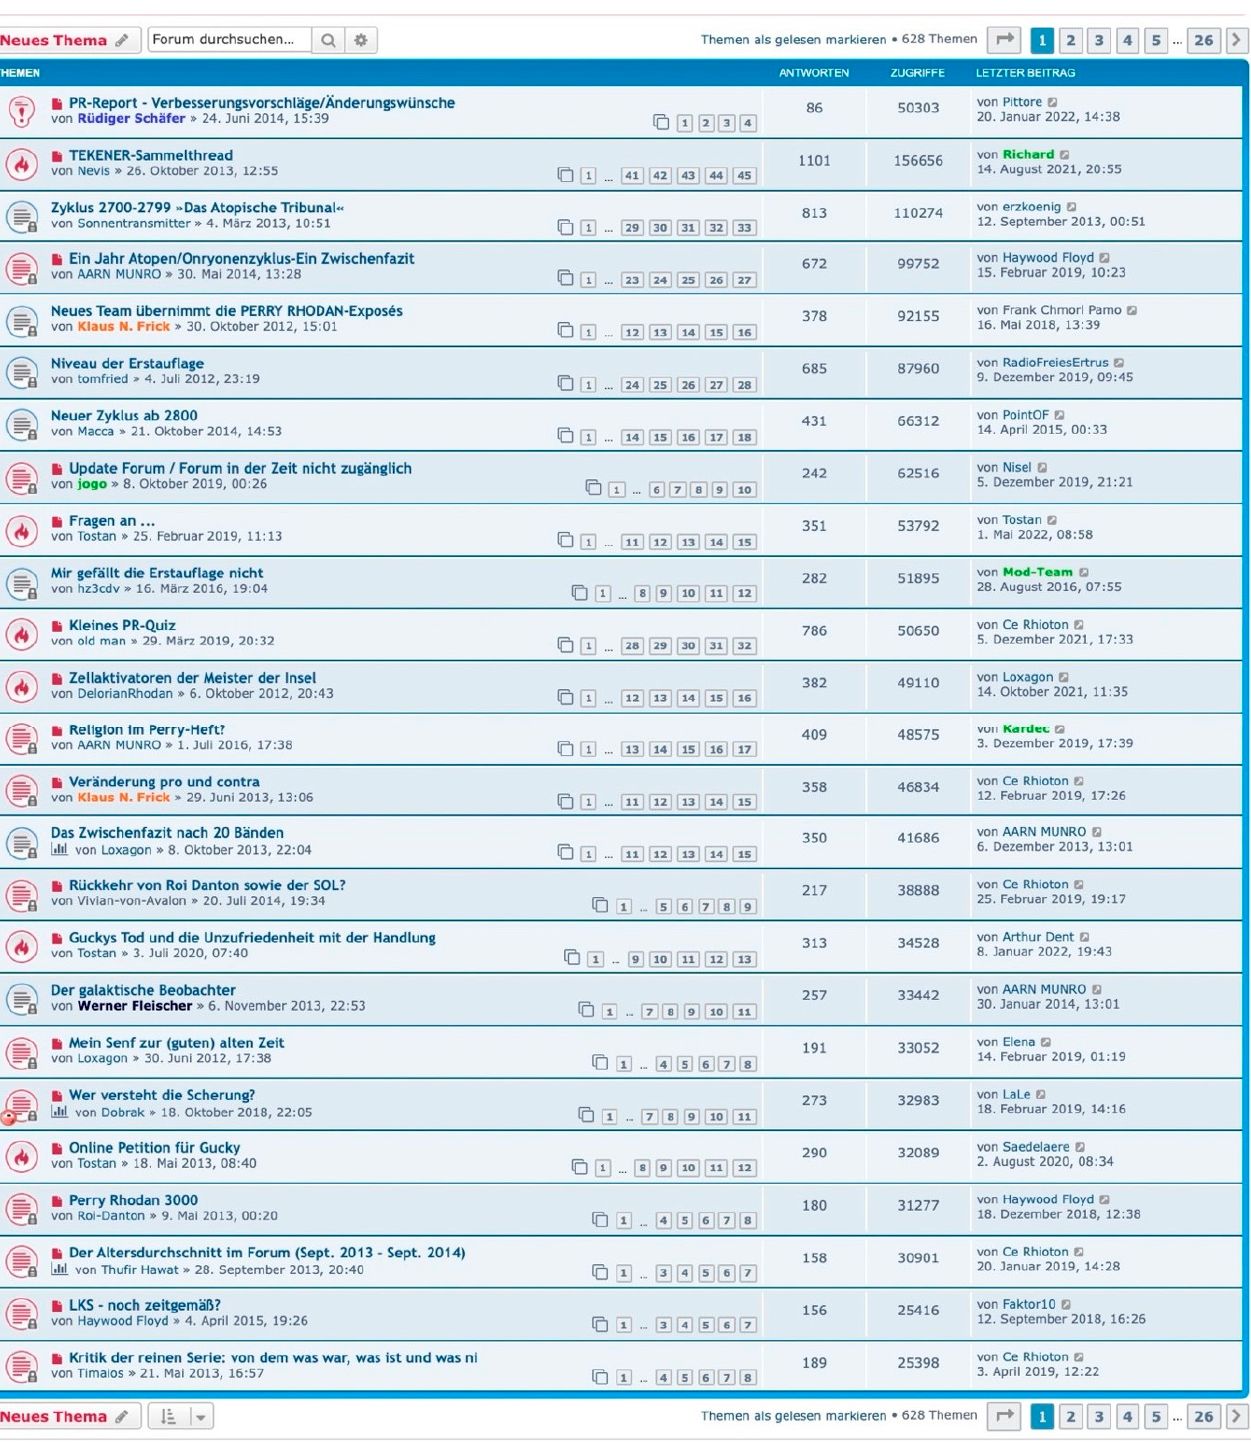
Figure 6. Perry Rhodan subforum issue series EA, sorted by the number of hits. The threads are also displayed—and can be sorted—by the number of posts to a topic ( replies ), by the topicality of the posts, and by authors . The participation in a thread can also be read graphically by the number of pages in the forum the posts cover, e.g., 4 pages to the first thread, but 45 pages to the second thread.